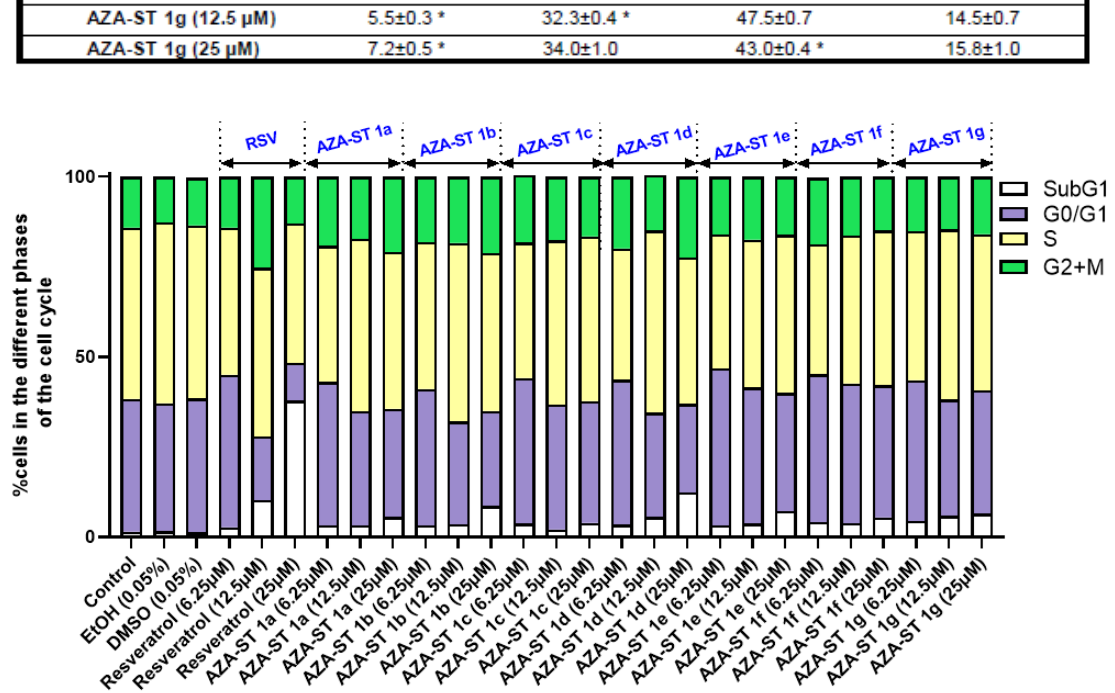
Figure 10. Quantification of the cells in SubG1 and in the different phases (G0/G1, S and (G2+M)) of the cell cycle. N2a cells were incubated for 24 h with or without AZA-ST 1a–g or resveratrol (RSV; trans -resveratrol) at concentrations inclosing the IC50s (6.25, 12.5 and 25 µ M). Vehicles (Ethanol